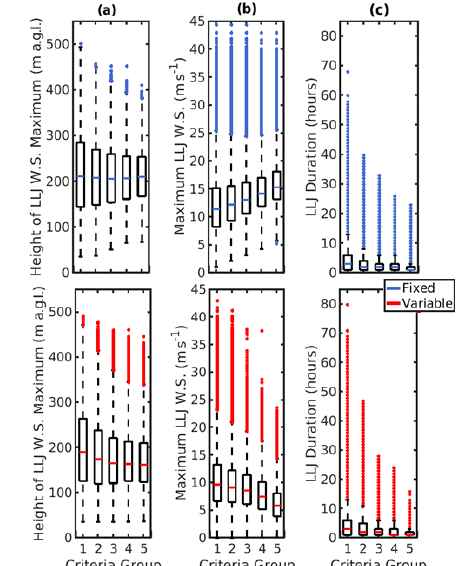
Figure 9. Box–whisker plots for definition-wise distributions of spatiotemporal LLJ characteristics: (a) jet core height, (b) jet core speed and (c) jet duration over the entire domain. Note: the whiskers on the boxplots extend from the 75th percentile to + 1 . 5 times the inter-quartile range and from the 25th percentile to 1.5 times the inter-quartile range. Points beyond those values are defined as out- liers and plotted as individual